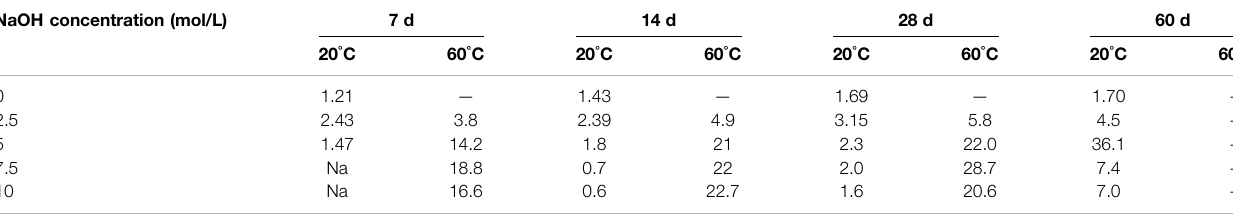
TABLE 2 | UCS of specimens prepared with NaOH activator (MPa). NaOH concentration (mol/L)